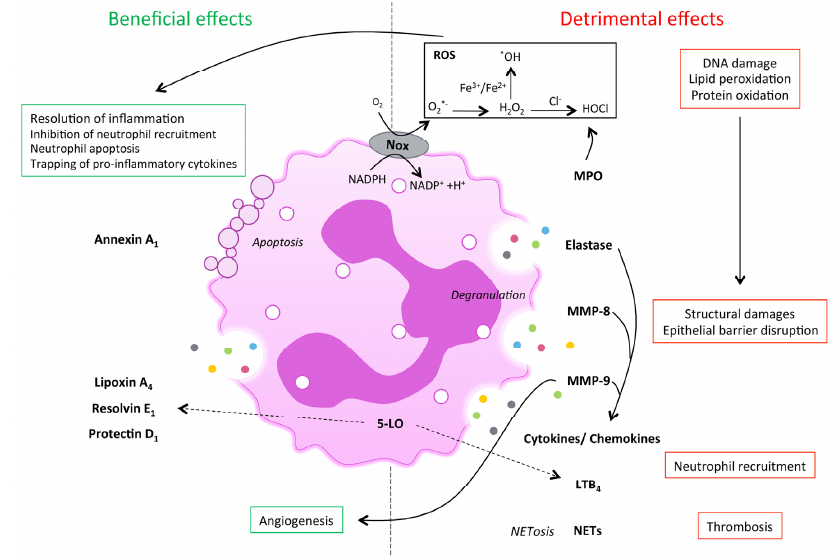
Figure 1. Dual role of neutrophils in intestinal inflammation. Excessive or prolonged neutrophil activation can lead to chronic inflammation in inflammatory bowel disease (IBD). Reactive oxygen species (ROS) production causes damage to DNA, lipids and proteins, altering their